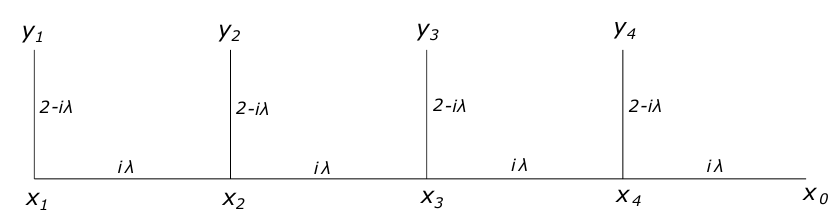
Figure 5 . Graphical representation of the kernel Q ( x 1 , . . . , x N , x 0 | y 1 , . . . , y N ; − iλ ) of the operator Q ( − iλ ) at the size N = 4 . The lines are functions 1 /x 2 to the power written aside; integration points y are marked by black dots and external points x k the kernel is a proportional to a portion of scalar Feynman integral in 4 d